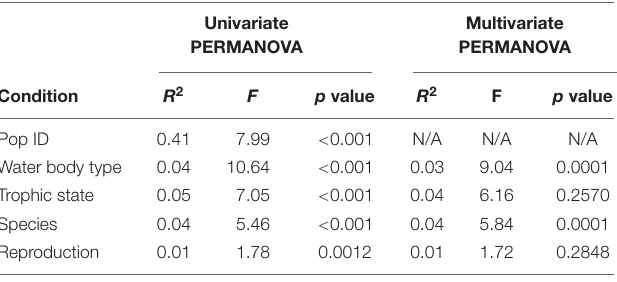
TABLE 3 | Statistical analysis of biotic and abiotic factors determining diversity of the associated bacteria of Hydra . Univariate linear model